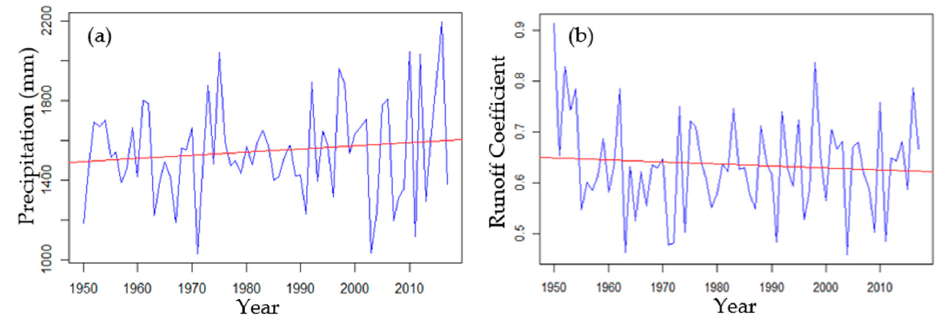
Figure 10. The variation of the lowest water level along the lower reach of the Min River.